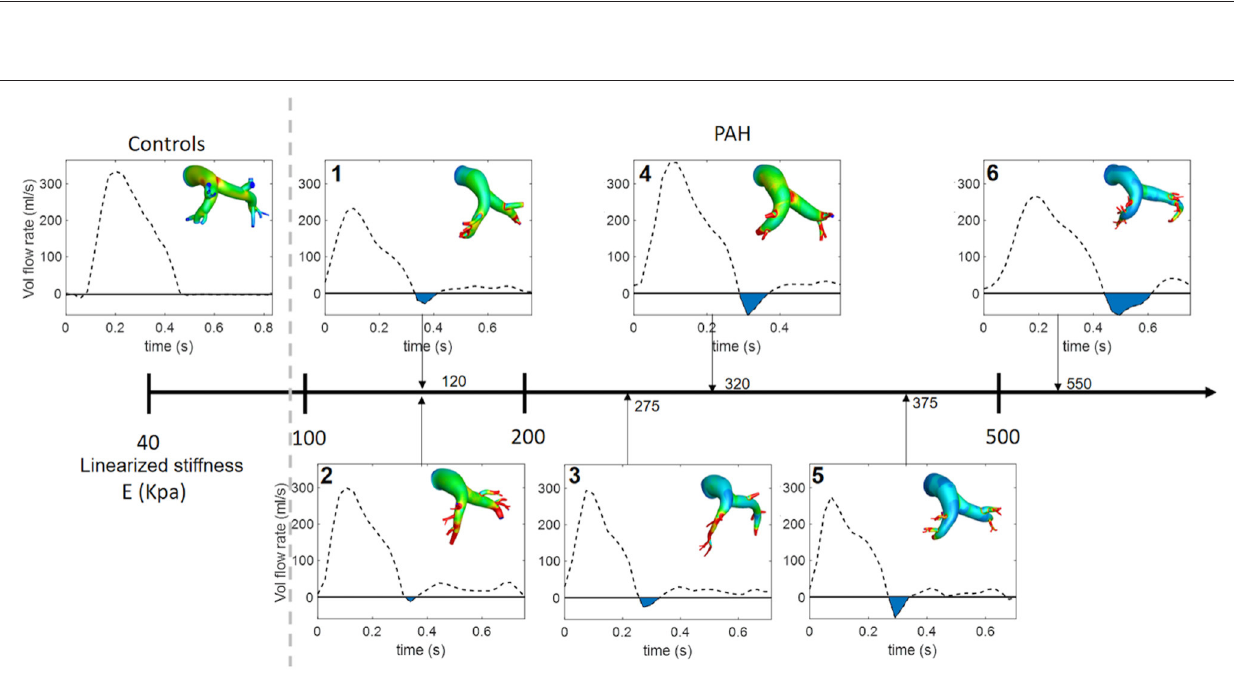
FIGURE 4 | Volumetric flow waveform of control subject CTL-2 as an example of the characteristic wavefrom in controls (left) and measured waveforms for each PAH patient arranged with increasing linearized stiffness E . Blue shaded region denotes total regurgitant flow in the proximal PA. The color countour, which is used in Figure 3 . represents the maximun surface